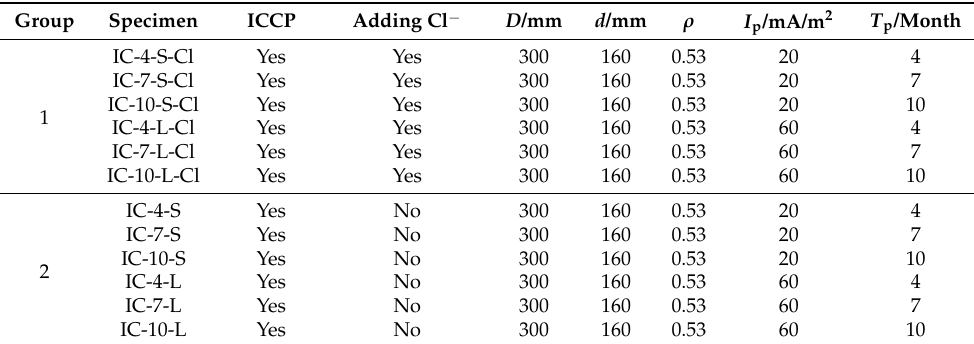
Table 2. Details of specimens under the protection of ICCP-SS